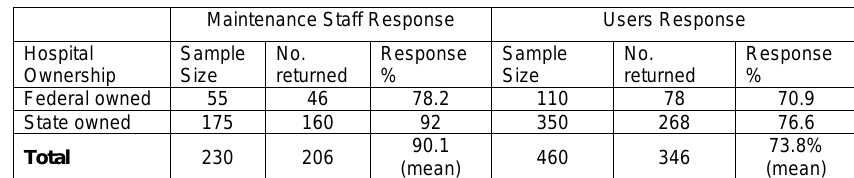
Table 2: Public hospital ownership